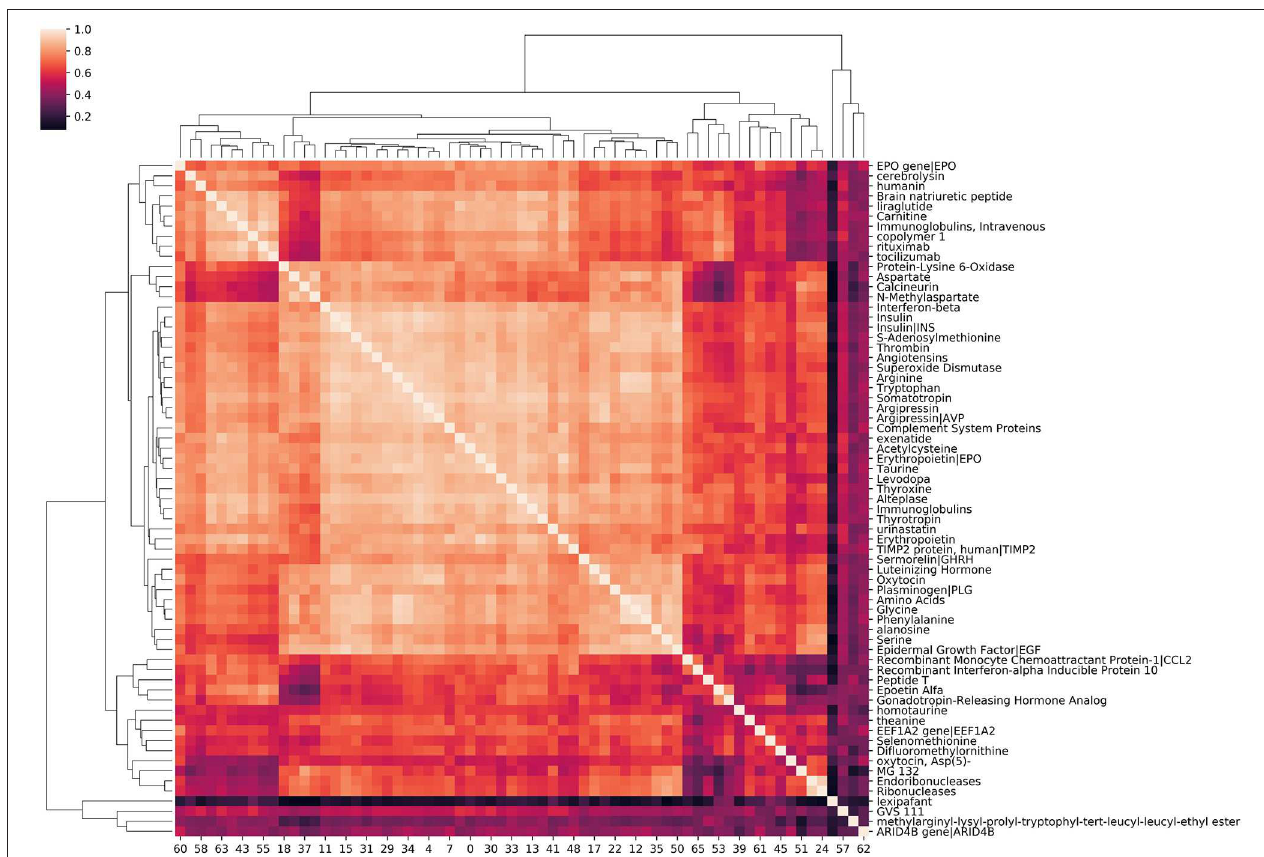
FIGURE 4 | A hierarchical clustering of amino acids, peptides, and proteins associated with “impaired cognition.” The intensity of the heatmap corresponds to the similarity of each concept pair’s relationship with impaired cognition. Similarity values are cosine similarities of metapath count features. Examining correlation among source nodes helps the user to assess underlying hierarchical concepts that could be driving the source node